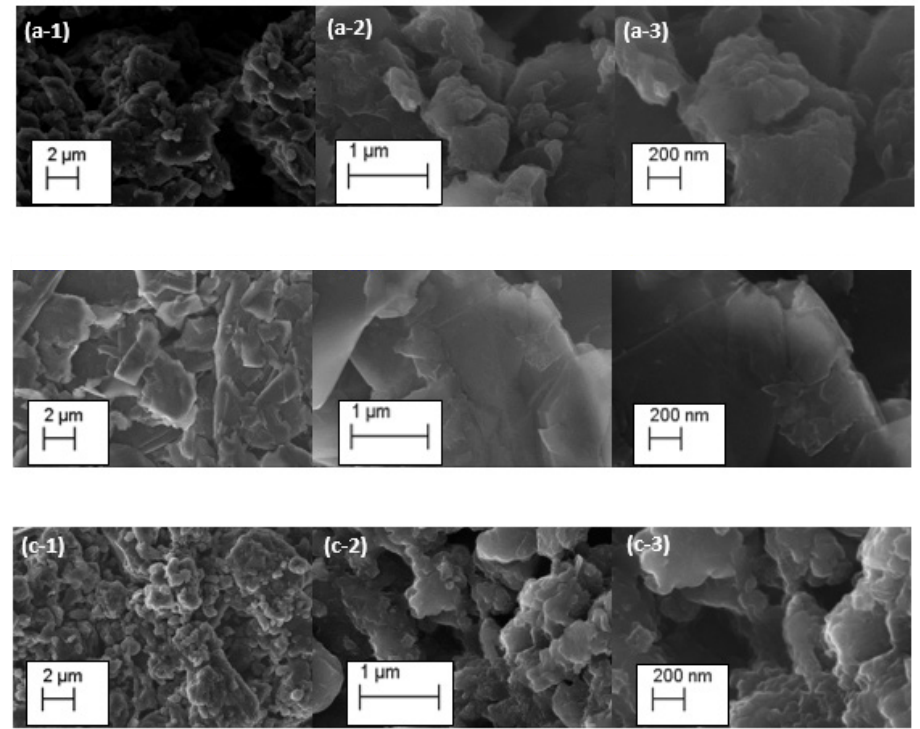
Figure 3: SEM images of (a) 100% PANI (b) 100% SLVG (c) 10%/90% SLVG/PANI